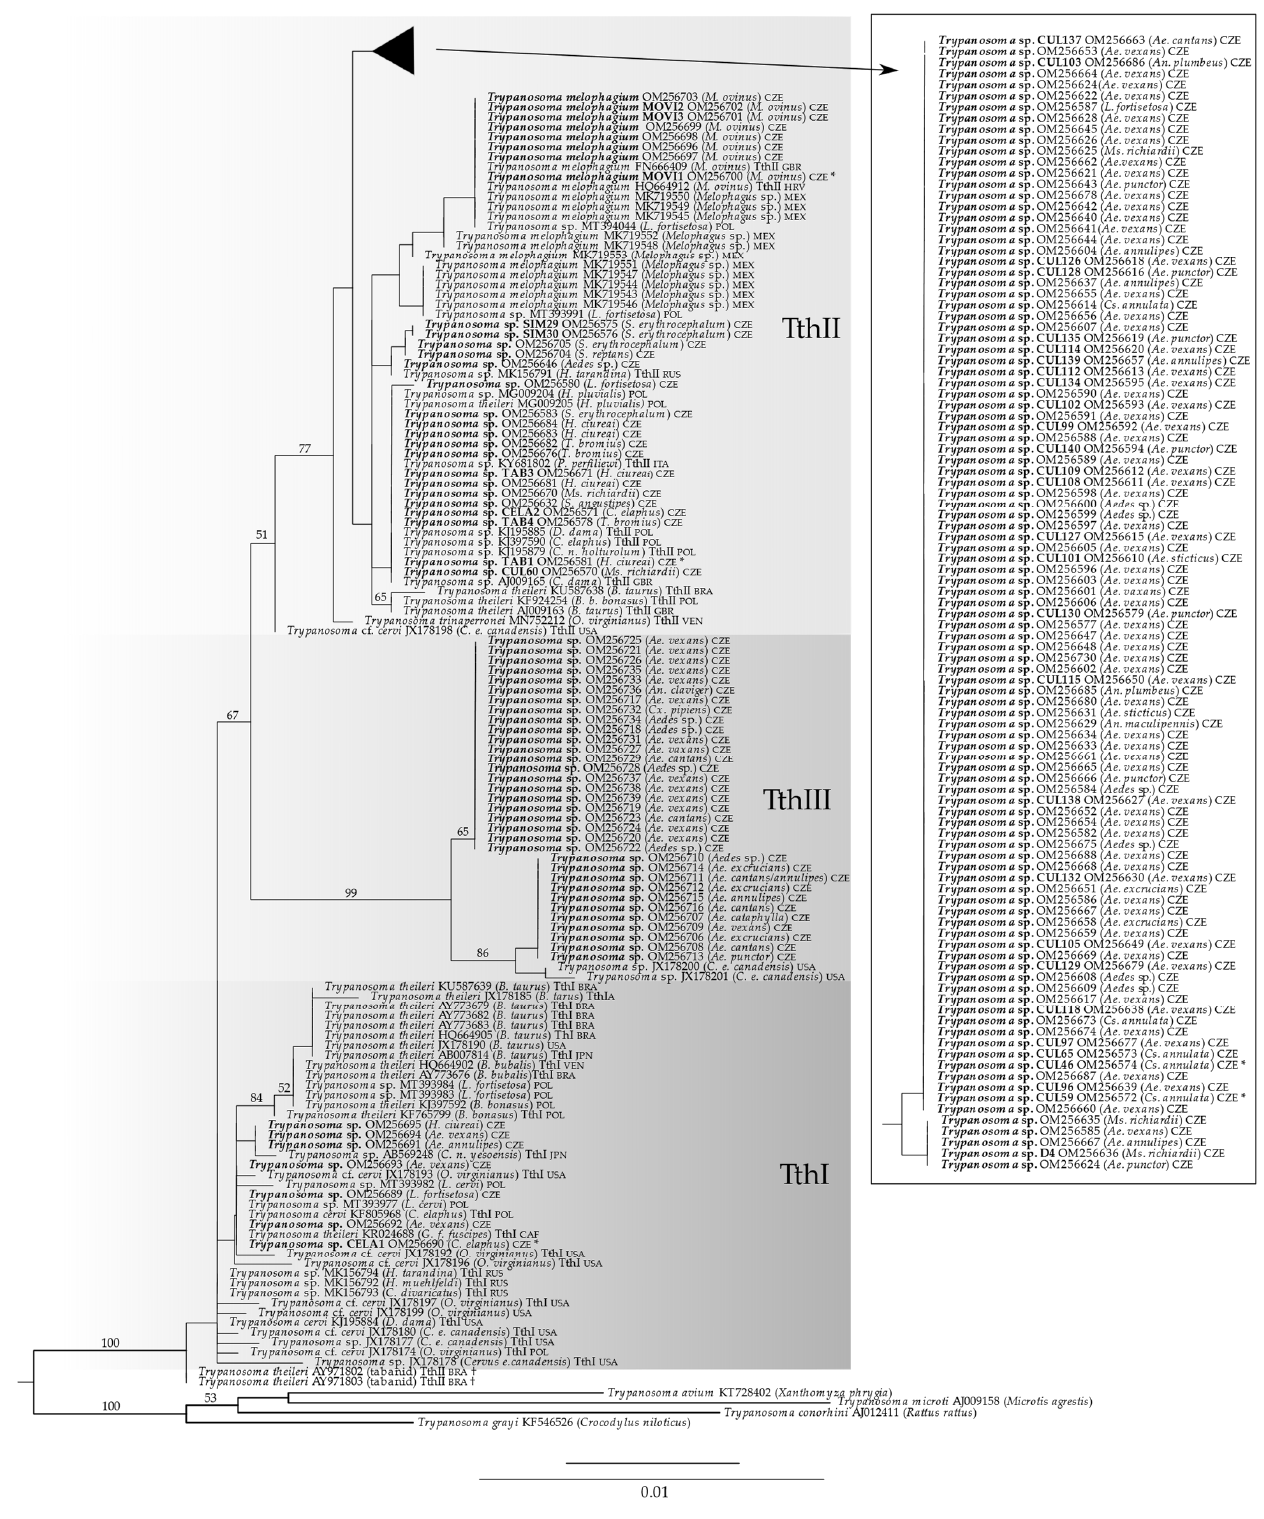
Figure 6. Phylogenetic tree of the Trypanosoma theileri group based on the 18S rRNA gene analysis. The tree was constructed using the maximum-likelihood method in RAxML (GTRGAMMAI model). Bootstrap values are shown at nodes. Newly determined sequences in bold. Cultures used in the infectious experiments are marked with asterisks. Daggers mark sequences which we do not consider to belong to TthII. The host species name is given in parentheses, followed by reported genotypes and abbreviations of the country of origin.